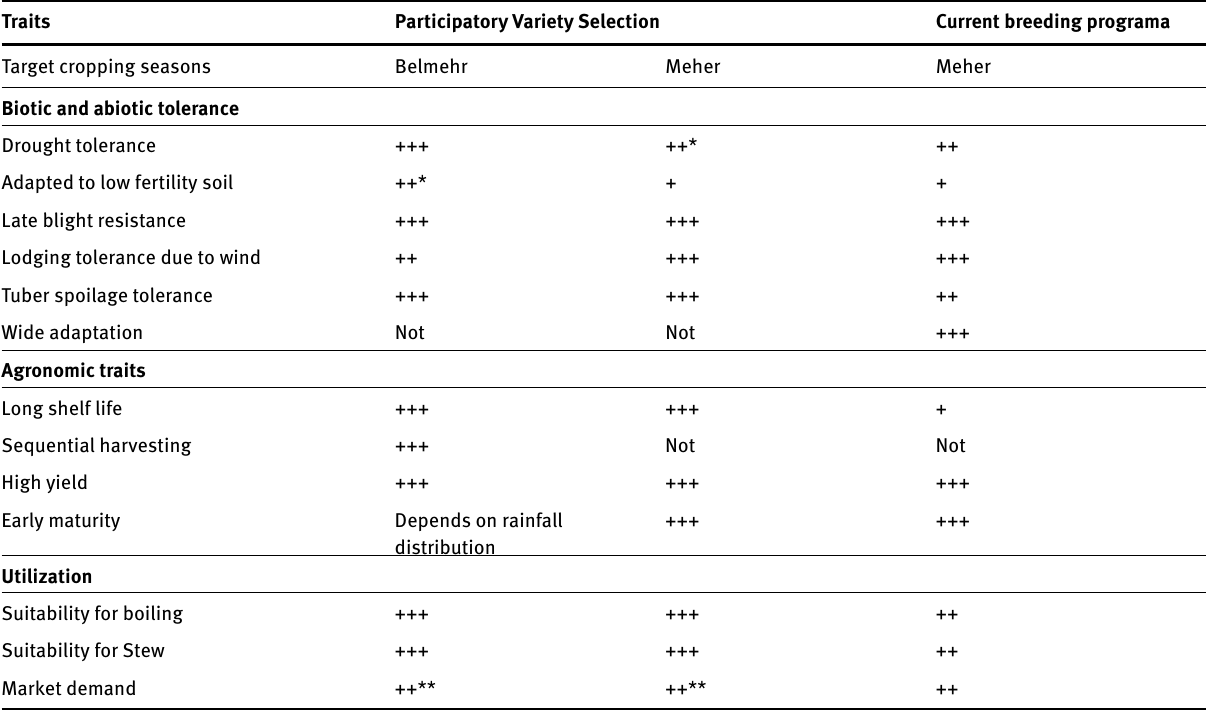
Table 4: Traits of importance revealed by Participatory Variety Selection (PVS) compared to current traits of emphasis in the national potato breeding program